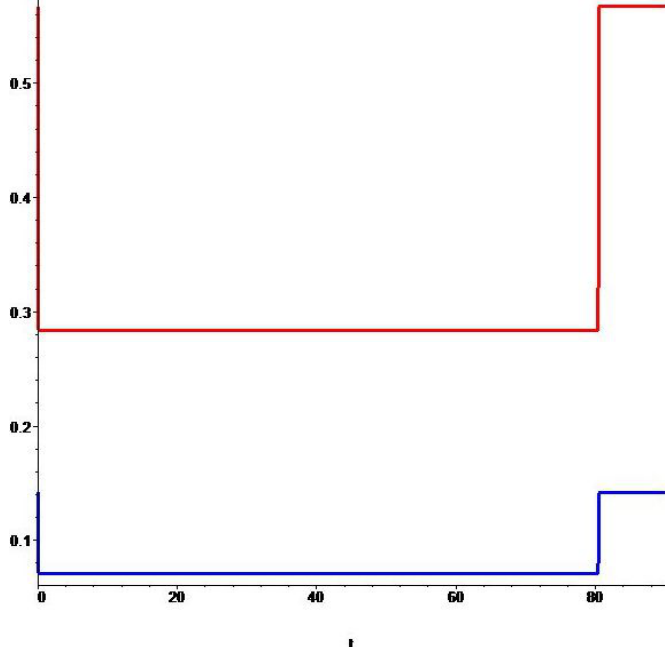
( t ) , v ( t ) for the Ebola outbreak in Zaire (1976) ∗ ∗